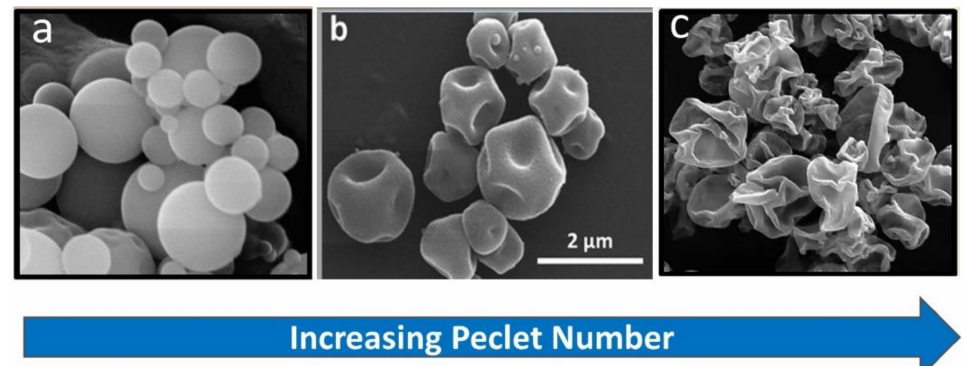
Figure 3. Scanning electron microscopy images of anti-TSLP Fab (CSJ117) particles spray dried with increasing Peclet numbers: ( a ) smooth spheres with 0% trileucine (Lot A7), ( b ) dimpled spheres with 2.5% trileucine (Lot A1), ( c ) corrugated spheres with 15% trileucine (Lot A13)